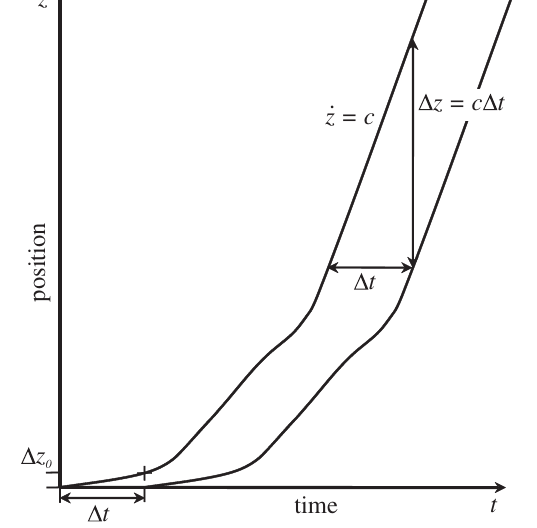
FIG. 1. Schematic illustration of the acceleration of two electrons in a static field. The spatial distance of the electrons expands during the acceleration and approaches the value Δ z ¼ c Δ t